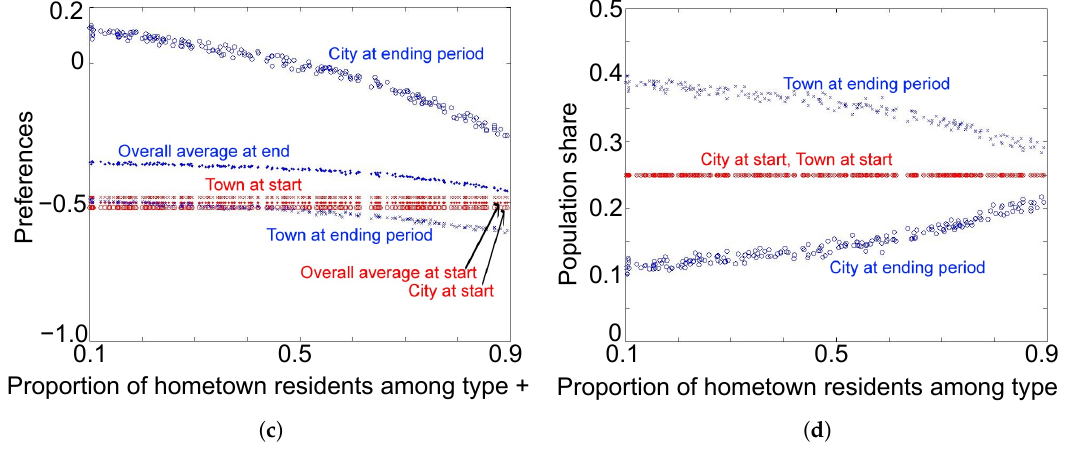
Figure 4. The Monte Carlo simulation with varying initial share of hometown among ethnicity ⊕ . Notation follows that of Figure 3a. ( a ) average preferences of ethnicity ⊕ ; ( b ) population shares of city and town + ; ( c ) average preferences of ethnicity (cid:9) ; ( d ) population shares of city and town −